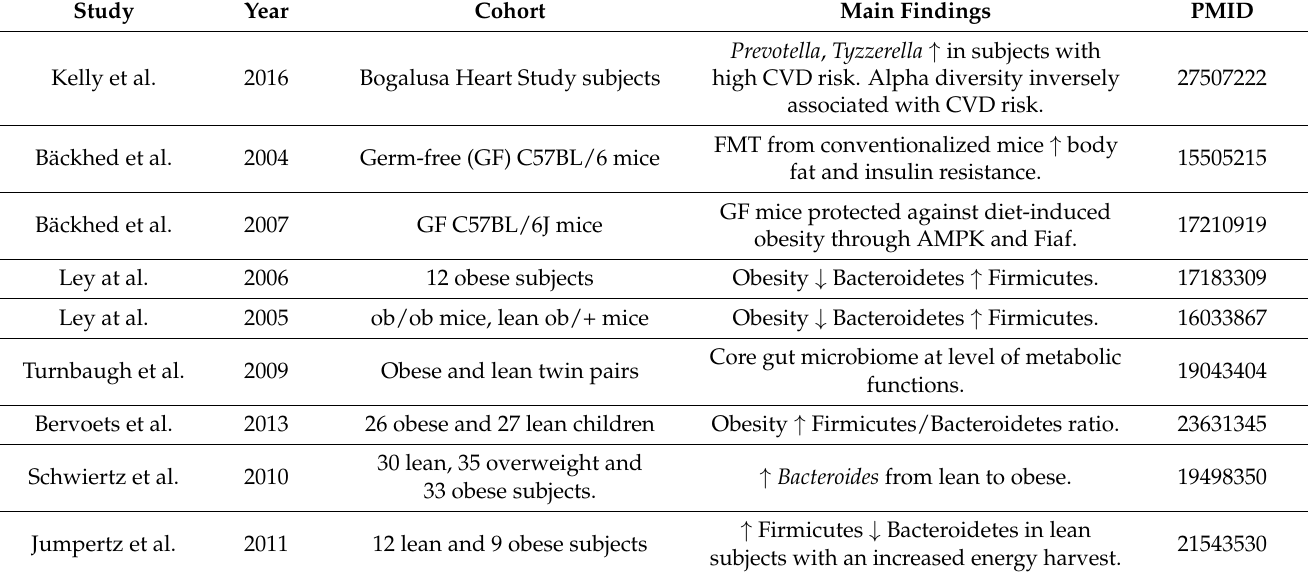
Table 1. Comparison of published studies of gut microbiome in